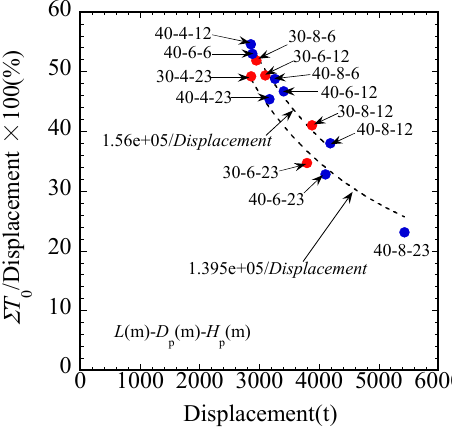
Fig. 15 Relationship between displacement and total initial